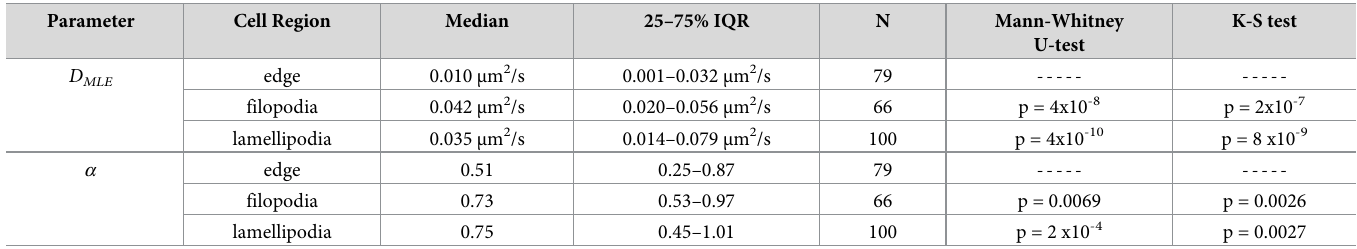
Table 1. Cell region dependence of diffusion